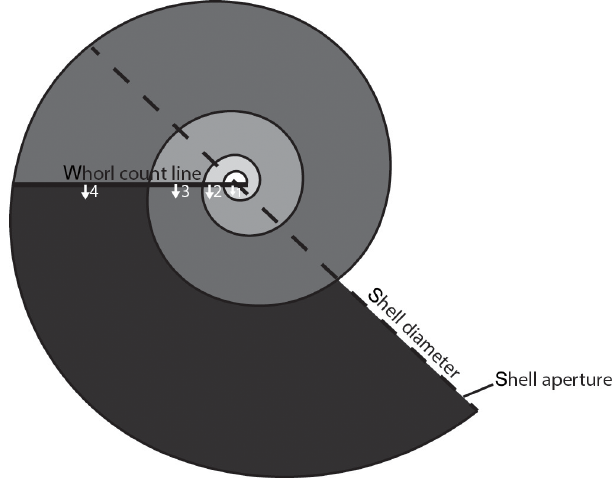
Figure 3. Schematic diagram of a pteropod shell demonstrating how shell diameter (the metric used for size) was measured and how the number of whorls was counted. Following the methods outlined in Janssen (2007), a straight line is drawn across the shell separating the semicircular nucleus (center) from the rest of the shell. Whorls are then counted as 360 ◦ rotation from the straight line, marked in progressively darker shades of grey, until the aperture of the shell is reached. The number of whorls is recorded with an accuracy of an eighth of a whorl. The shell in the schematic diagram has 3 3 / 8